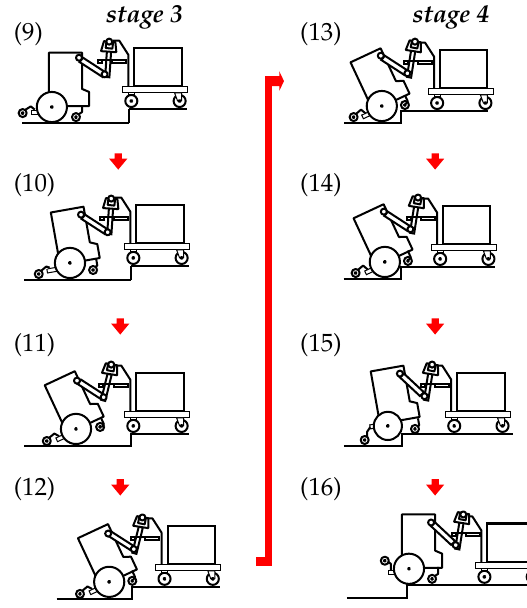
Figure 16. Step-climbing process of the robot